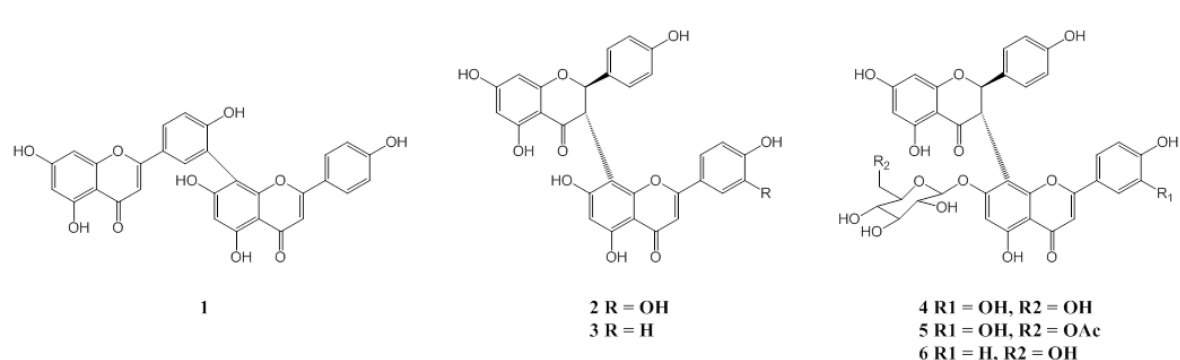
Figure 1. Chemical structures of compounds 1 – 6